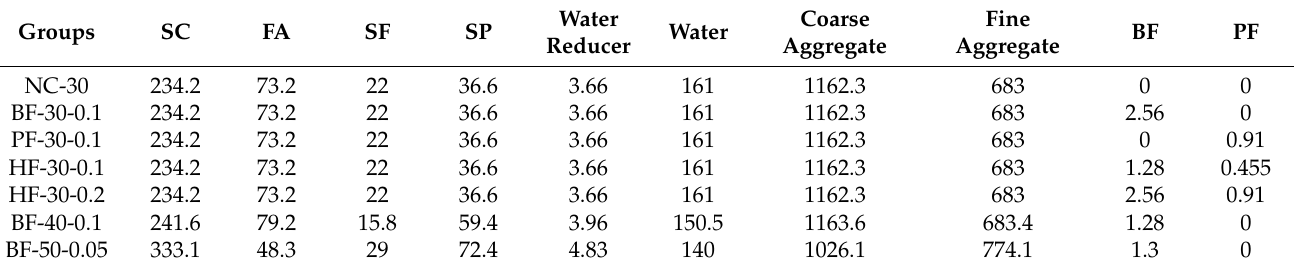
Table 4. Mixture ratio of BPFRC (kg/m 3 ).